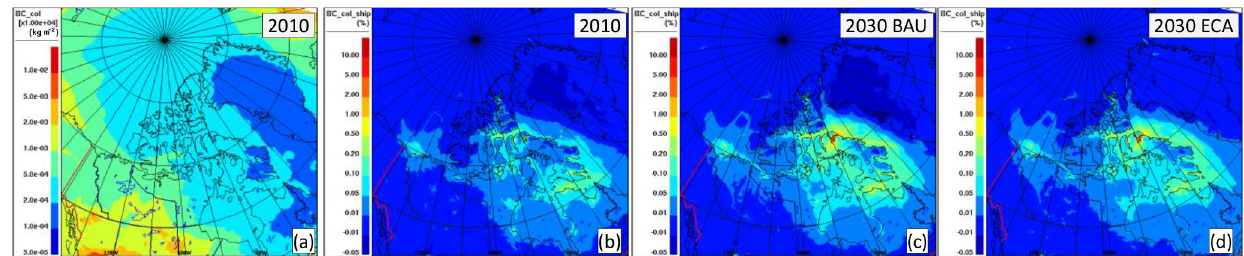
Figure 18. Modelled BC column loading (scaled up by 10 4 , in kgm − 2 ) averaged for over the 2010 July–August–September period (a) , and relative contributions from Canadian Arctic shipping emissions: (b) 2010 base year, (c) 2030 BAU, and (d) 2030